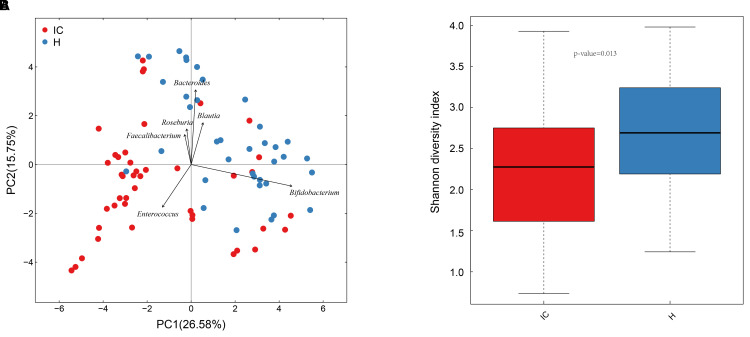
Principal component analysis (PCA) distribution and bacterial diversity in IC and healthy infants. (A) Using PCA analysis, the samples from the IC group were clustered together, and they were separated from those of the H group. The GM of the participants predominantly included Bacteroides, Bifidobacterium, and Enterococcus. (B) The diversity in the bacterial community was significantly lower in the IC infants (2.222 ± 0.790) than that in the H group (2.669 ± 0.753) (P = 0.013).